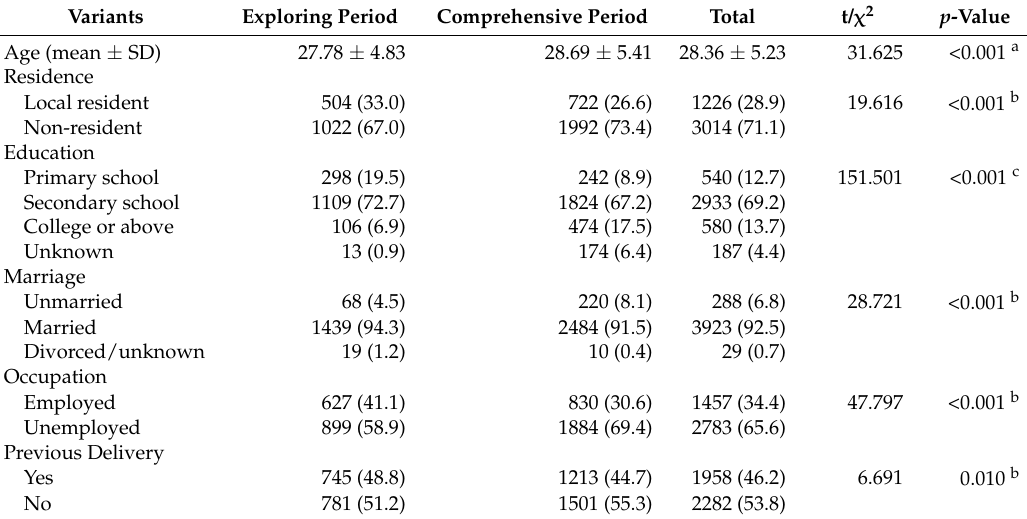
Table 1. Demographic characteristics of pregnant women with maternal syphilis in the exploring and the comprehensive period. ( n = 4240).